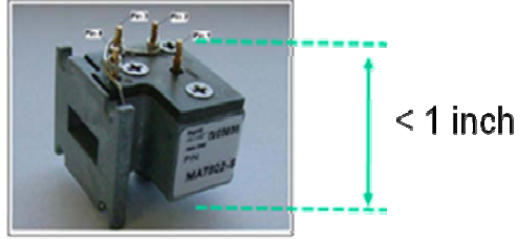
Figure 1. Miniature M/A-COM MACS-007802-0M1RSV K-Band Doppler transceiver